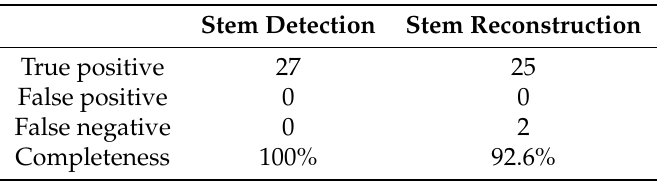
Table 2. Results of the stem detection rate and reconstruction rate.